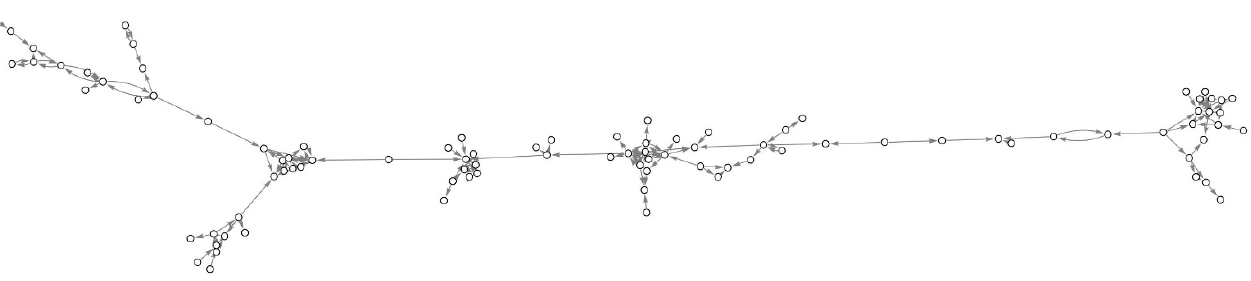
Figure 9. Supply Chain for first 4 days of July 2021. Largest component only. Standard member and chama nodes only.